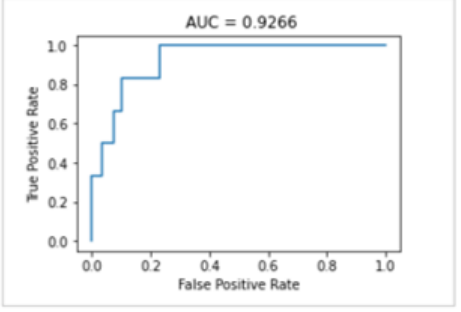
Figure 4. AUC and ROC curve of the Disney